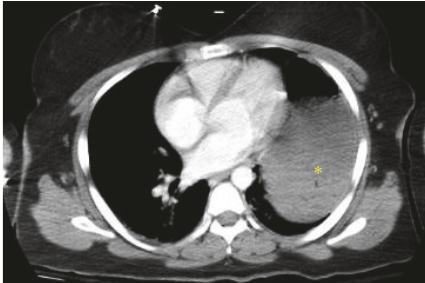
Figure 3: Postcontrast (intravenous) axial CT image confirms a fluid-filled viscus (yellow asterisk) in the lower left thoracic cavity.